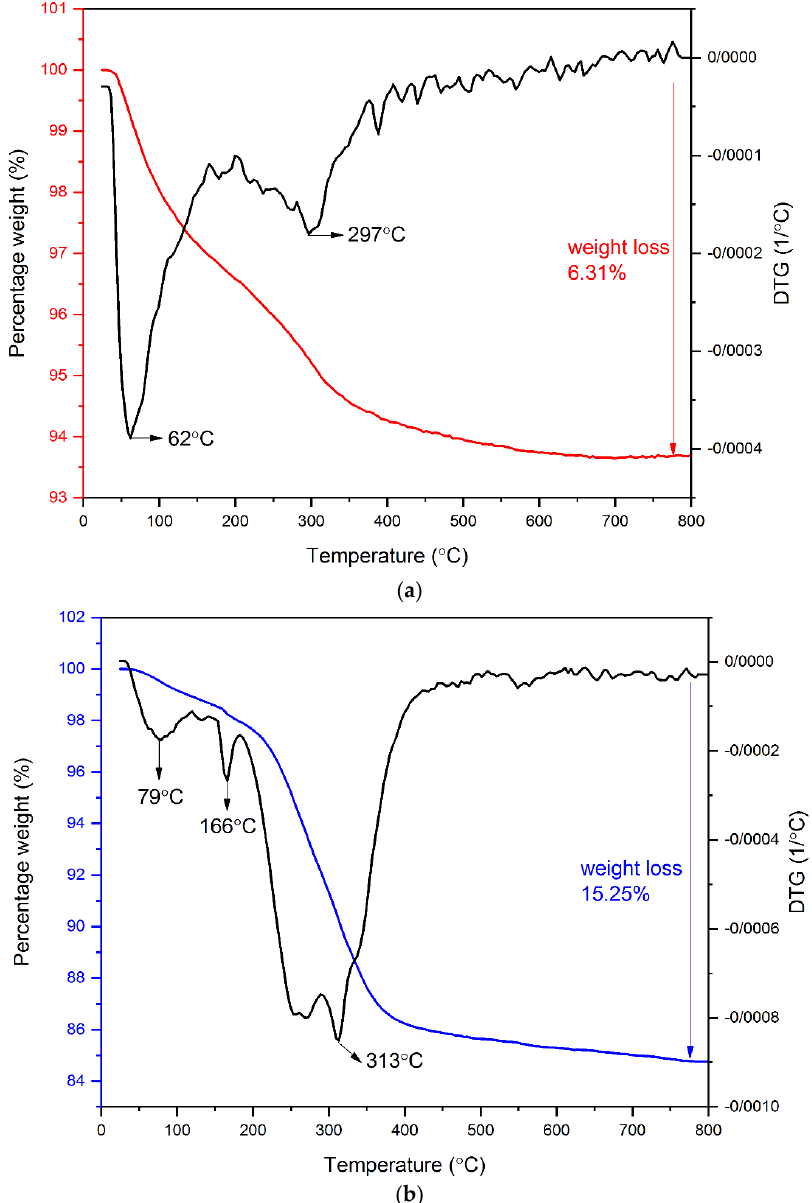
Figure 4. TG and DTG analysis of RMNPs ( a ), and DextCHO-RMNPs ( b ).